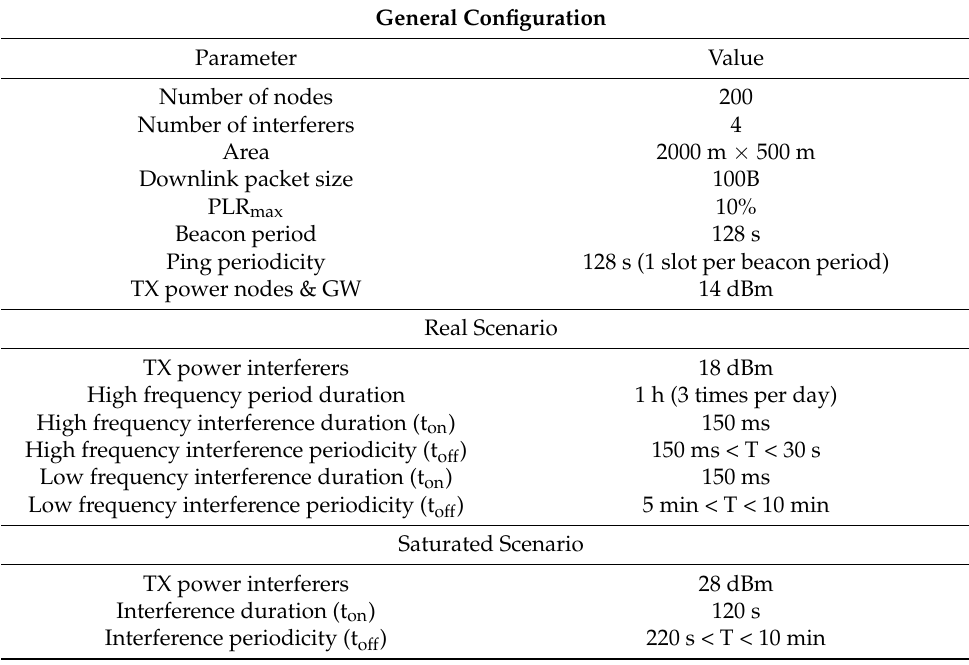
Table 2. Configuration parameters for